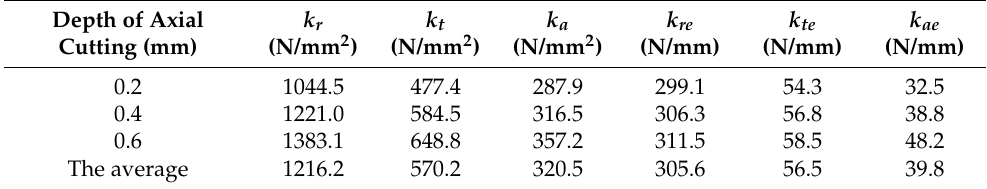
Table 8. Cutting force coefficients of helical milling on titanium alloy based on TriMule. Depth of Axial